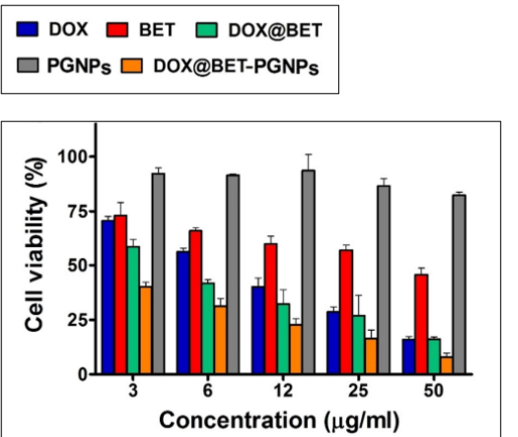
Figure 4. Cell toxicity results of MCF-7 cell line after treating them with individual and a combination of drugs encapsulated in gelatin nanoparticles. (DOX—doxorubicin; BET—betanin). (Reproduced with permission from [43]; Copyright 2019, Elsevier).